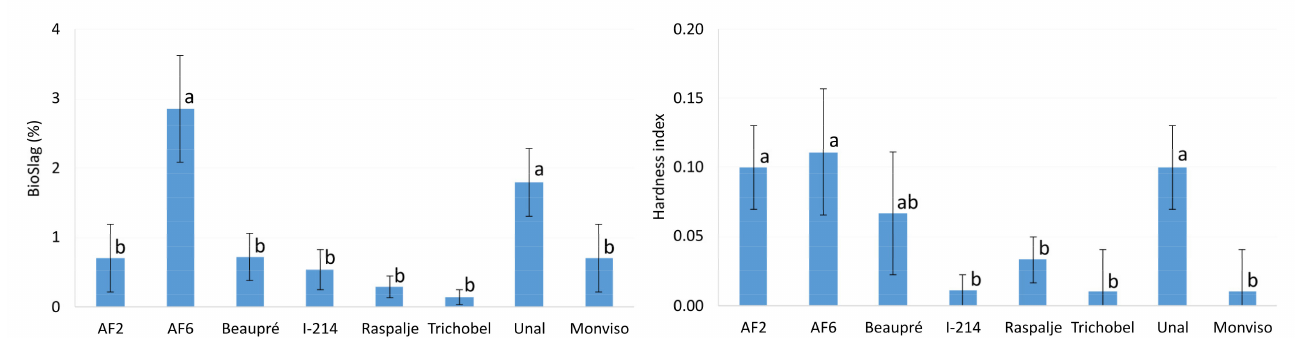
Figure 6. Mean values and standard errors for the BioSlag test (%) and the hardness index for sintered particles from the eight clones under study. Different letters denote significant differences (Tukey